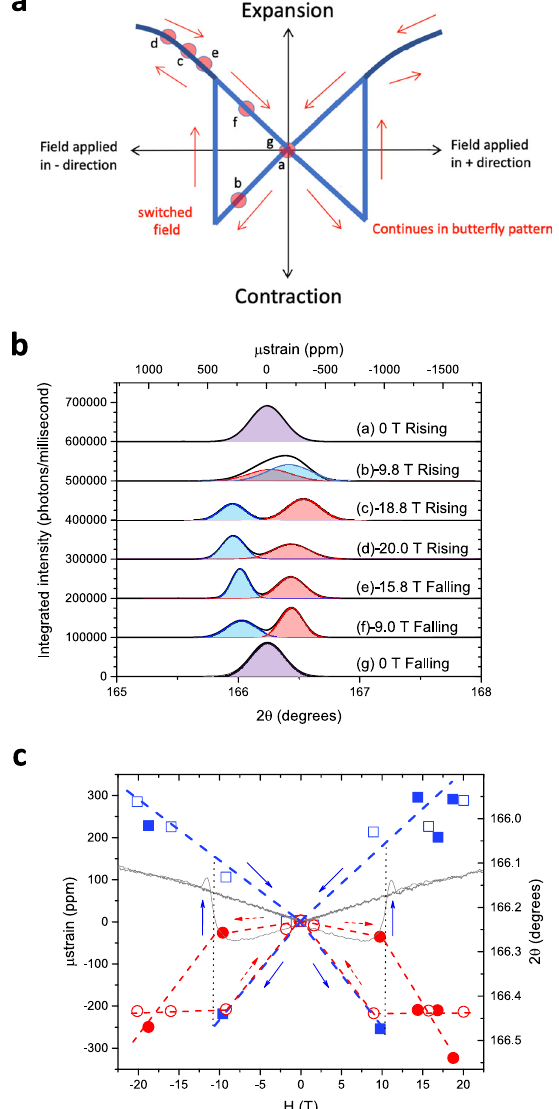
Fig. 3 The magnetostriction in the antiferromagnetic state of UO 2 — alternate fi eld directions. a A schematic diagram showing the bulk sample magnetostriction along the <111> direction in a magnetic fi eld applied immediately in the direction opposite to that of the previously applied fi eld (bold blue line). As opposed to Fig. 2a, the sample shows irreversible behavior by instead initially contracting in the <111> direction, but then rapidly switching back to the previous expanding behavior once a threshold fi eld has been surpassed. b The integrated intensity in 2 θ for selected fi elds and at temperature, T = 25K. As opposed to 2c, the higher 2 θ peak is initially larger, but then a change in relative intensities and peak position can be seen. c A plot of the relative strain calculated from the peak positions in the reversed fi eld state at 25K. The peak corresponding to the dominant strain behavior as determined by the bulk magnetostriction is the blue squares and the secondary peak corresponding to negative strain is the red circles. Note that the curves for positive fi elds are similar to the data in Fig. 3b. Open symbols are used for rising fi elds and closed for falling fi elds. The blue solid line is guide to the eye. The solid black line is the reversed fi eld measurements using the FBG technique taken in positive and negative fi elds at